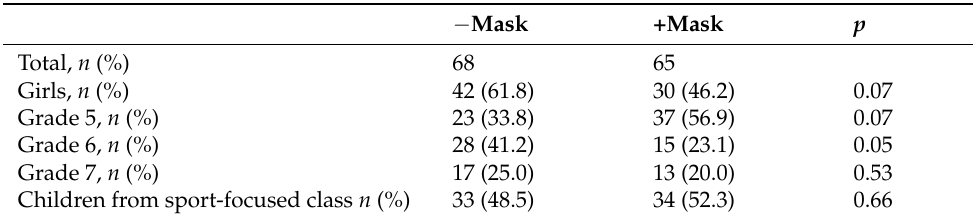
Figure 2. Flowchart—study design and population ( n number). Table 1. Demographic data: size of groups by grade level, sex and sport-focused class.